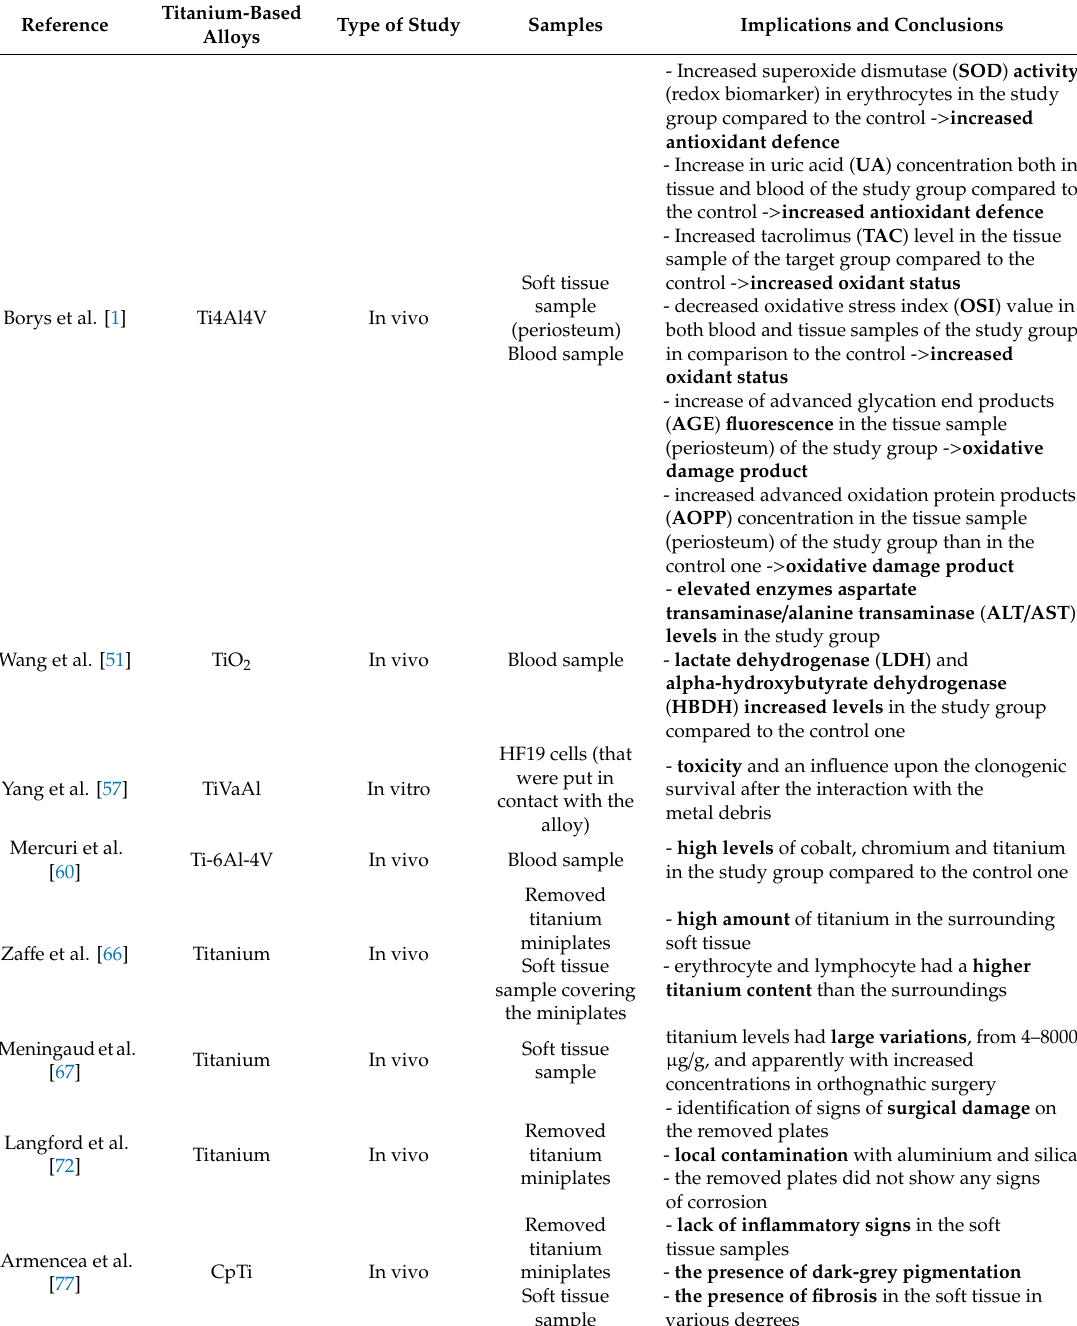
Table 3. Studies focused on titanium-based alloys and their